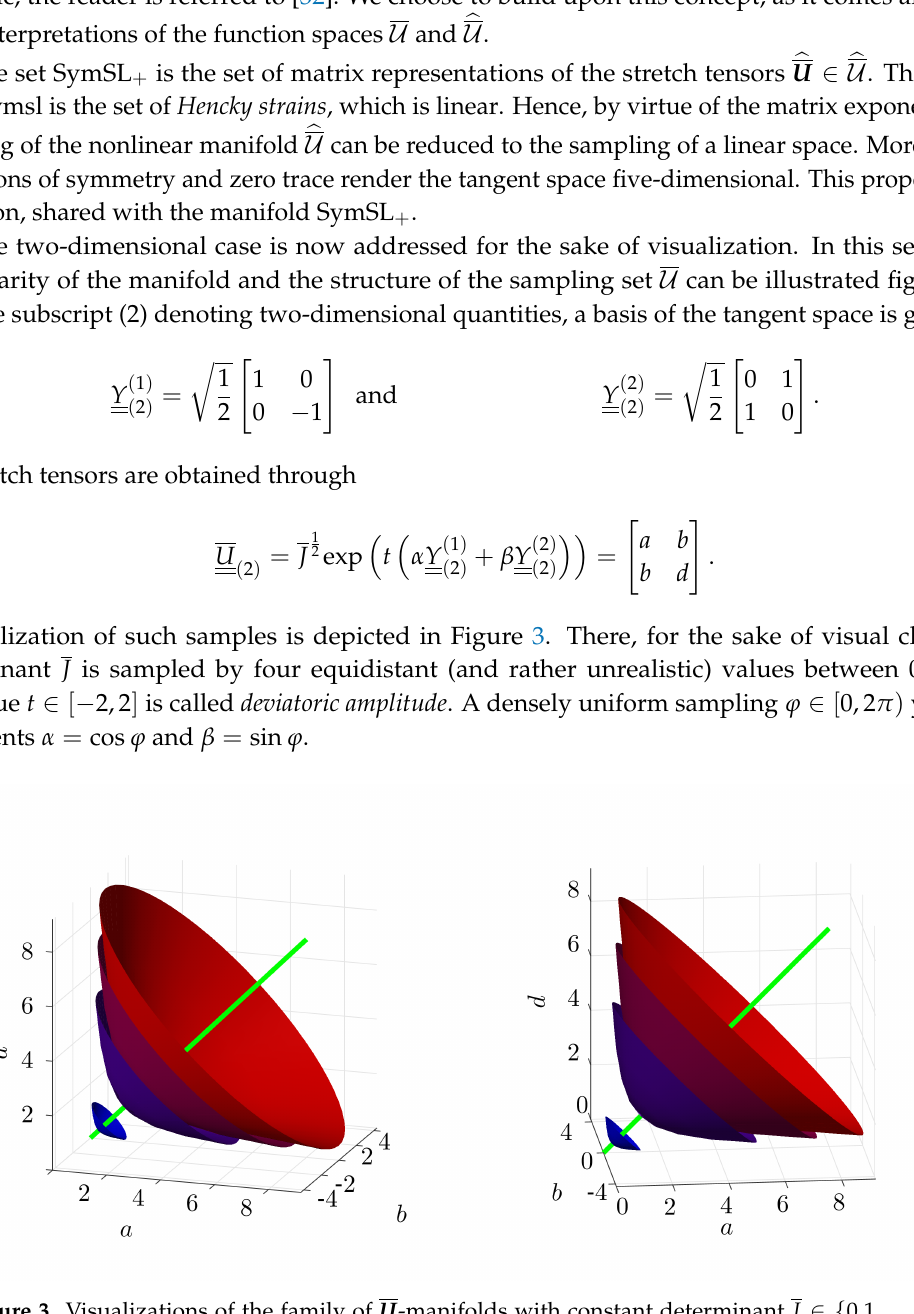
Figure 3. Visualizations of the family of U -manifolds with constant determinant J ∈ { 0.1, . . . ,4.0 } for the two-dimensional case from two different perspectives. The green line represents the set { λ I | λ > 0 }